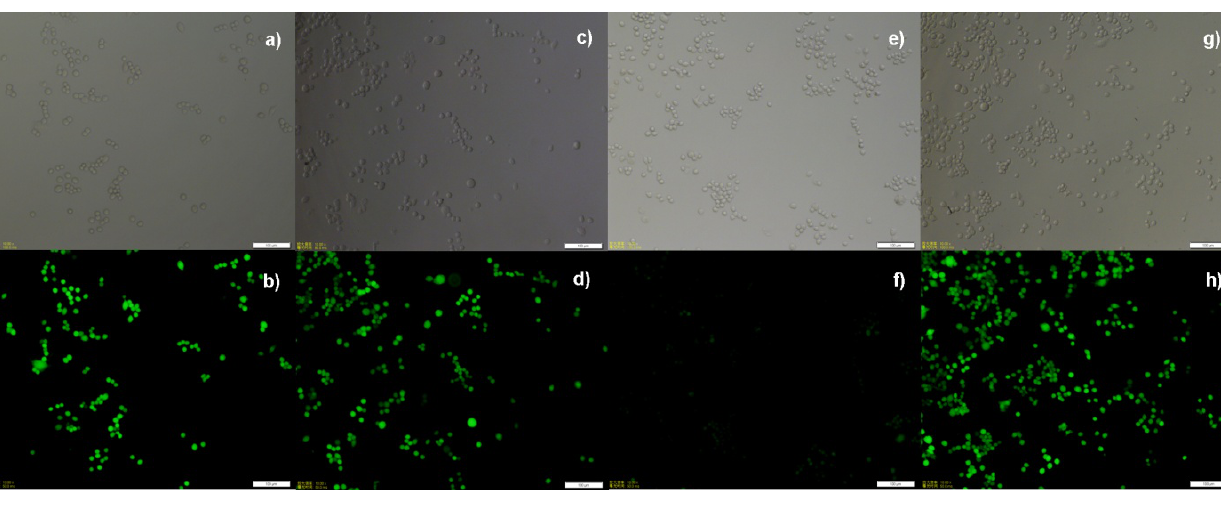
Figure 6. Fluorescence microscopy images of RAW 264.7 cells incubated with ( a , b ) free FDA; ( c , d ) free FDA followed by 15 min light irradiation; ( e , f ) FDA-loaded Np1 for 4 h and ( g , h ) FDA-loaded Np1 for 4 h followed by 15 min light irradiation. The concentration of FDA-loaded Np1 was 25 μ g/mL. (scale bar = 100 μ